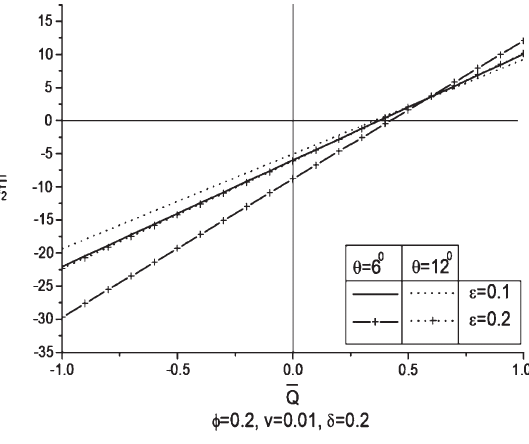
Fig.9. VariationofinnerFrictionforceversus t withdifferentvalues of the main flow rate Q . will increases as the eccentricity parameter (cid:2) increases. Also, (cid:9)p ( t ) will decrease as Q increases.